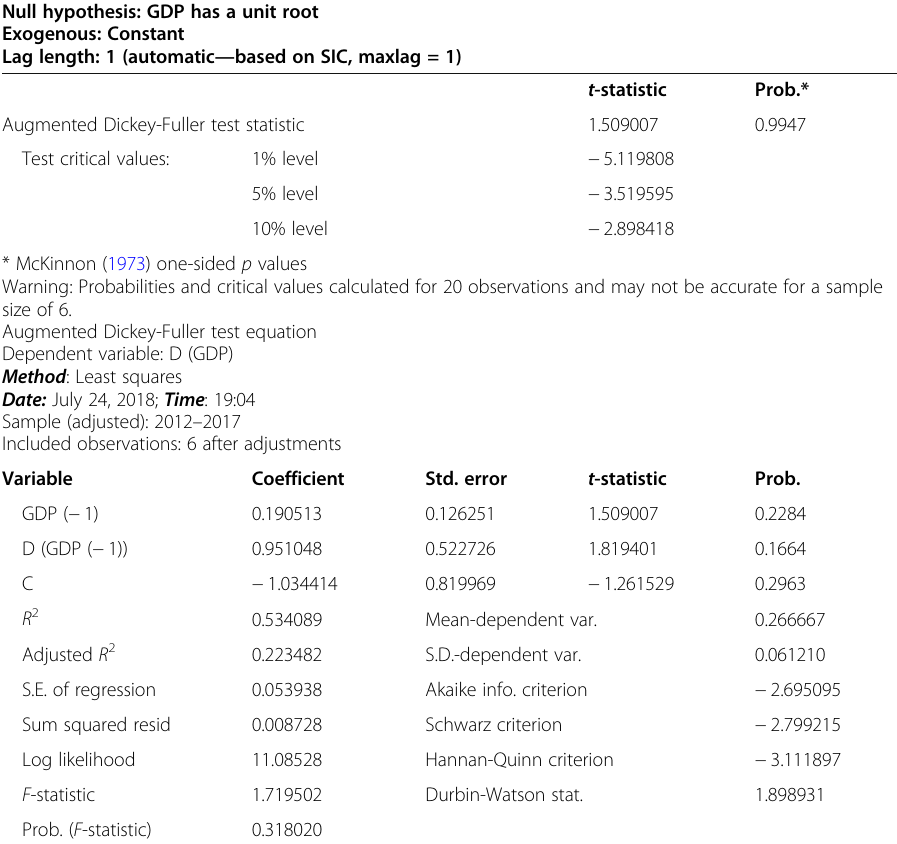
Table 2 Augmented Dickey-Fuller test for